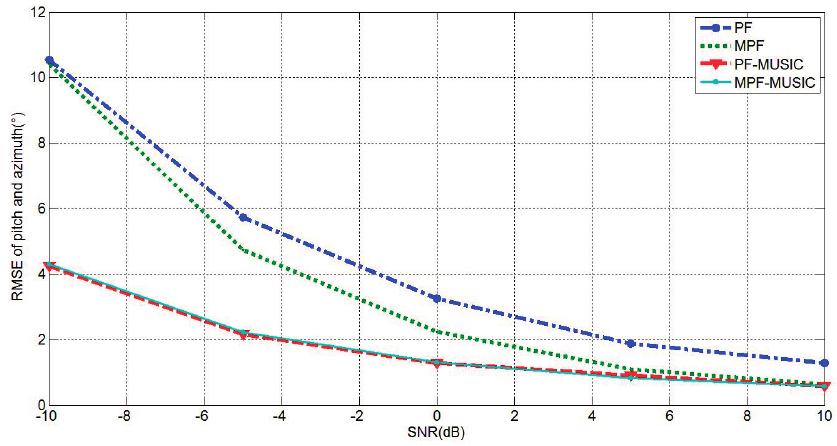
Figure 4. The RMSEs under different